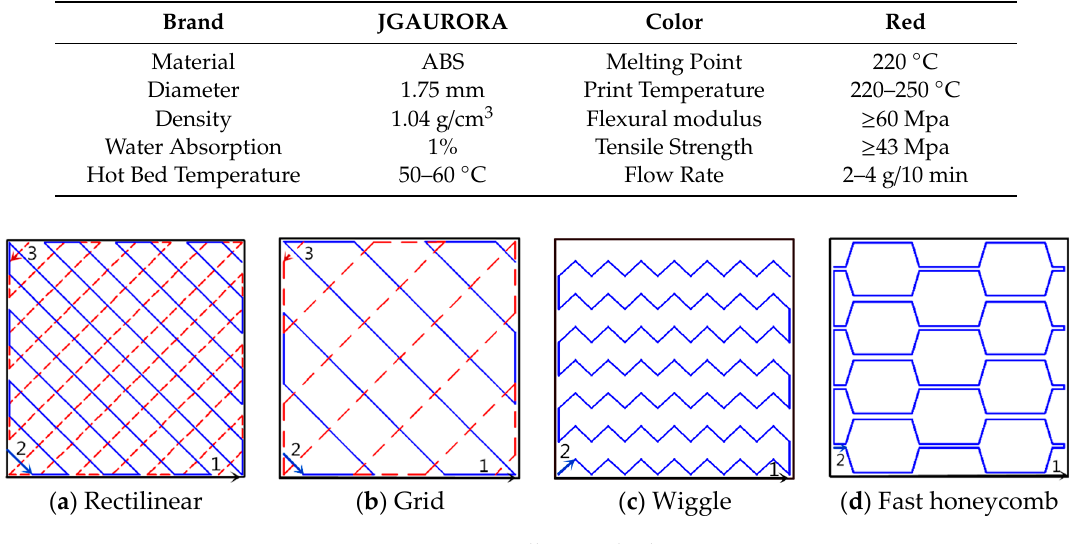
Figure 3. Filling method. Figure 3. Filling